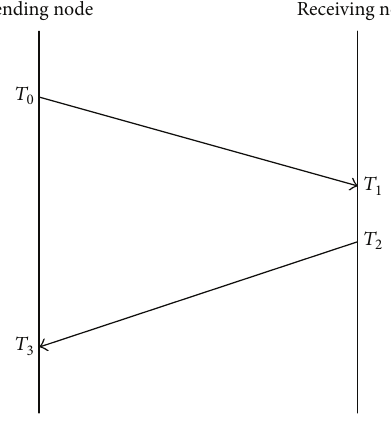
Figure 1: Round trip travel time.